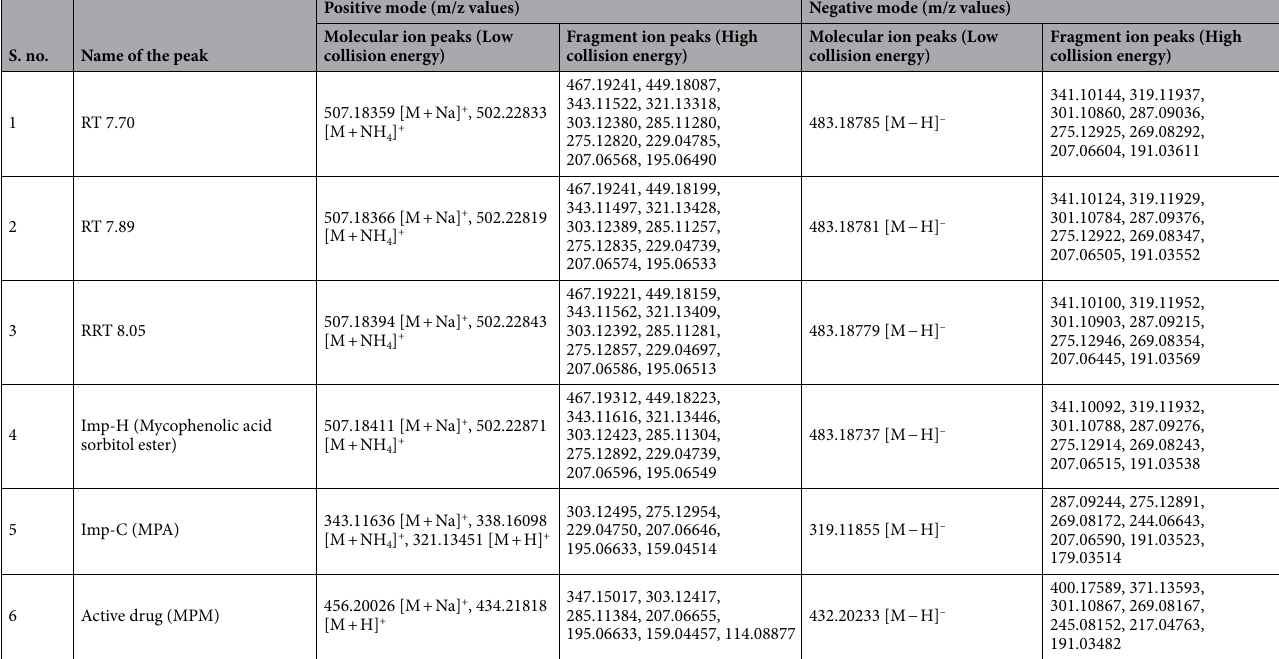
Table 5. Molecular and fragment ions peaks in positive and negative ionization